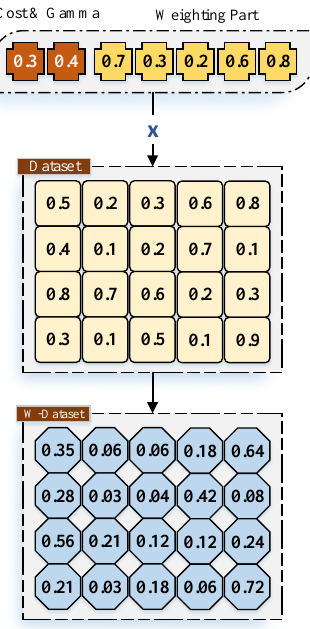
Figure 2. A simple example of the weighting